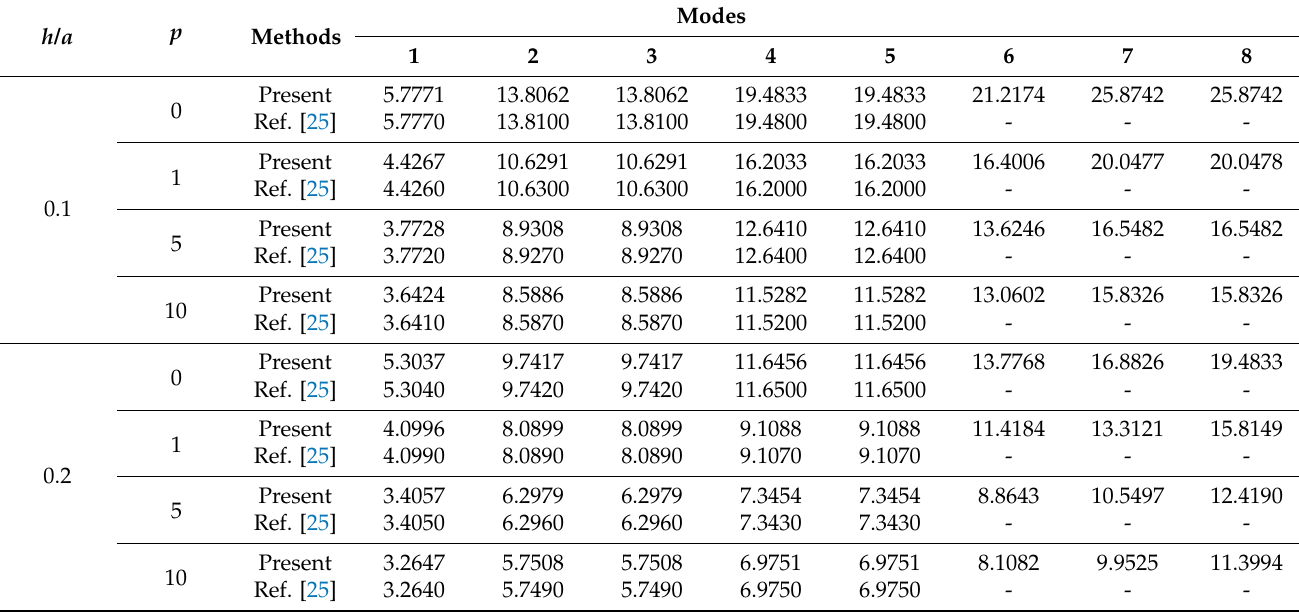
Table 3. The first eight non-dimensional frequency parameters of FGMs square plate without cutout under SSSS boundary (cid:112) ρ c / E c , a = b = 1 m). condition ( Ω = ω a 2 / h